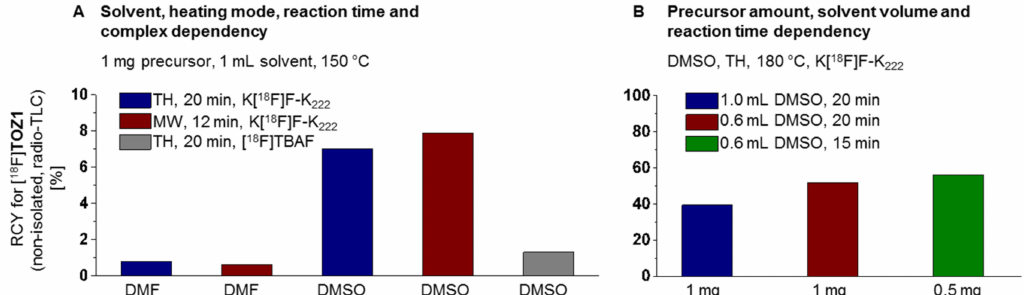
Figure 4. Investigated reaction conditions for the radiosynthesis of [ 18 F] TOZ1 : ( A ) solvent, heating mode (RCY = radio- chemical yield, TH = thermal heating, MW = microwave heating), reaction time, complex and ( B ) precursor amount, solvent volume, reaction